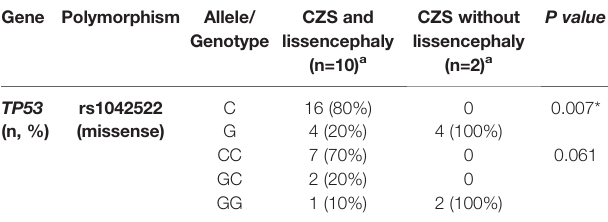
TABLE 2 | Allelic and genotypic frequencies of TP53 rs1042522 polymorphism in children with CZS and lissencephaly or with CZS and without lissencephaly. Gene Polymorphism Allele/